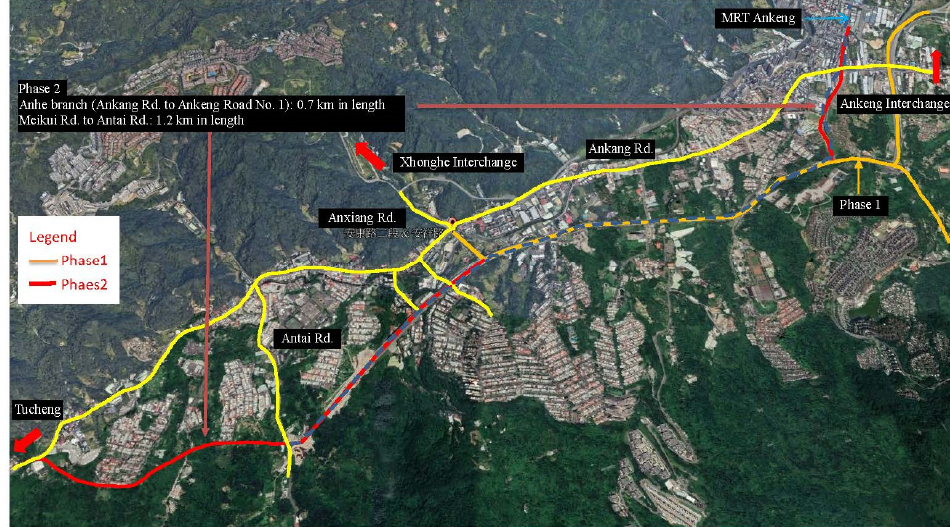
Figure 2. Schematic diagram of the project’s location and scope.